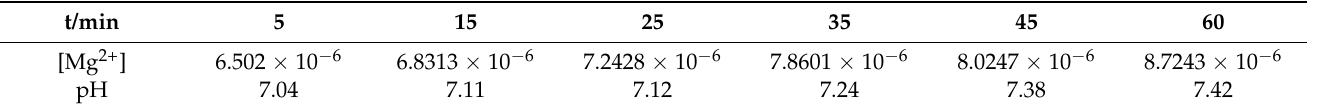
Table 3. [Mg 2+ ] and pH in the bulk solution for AZ91 alloy after immersion at different